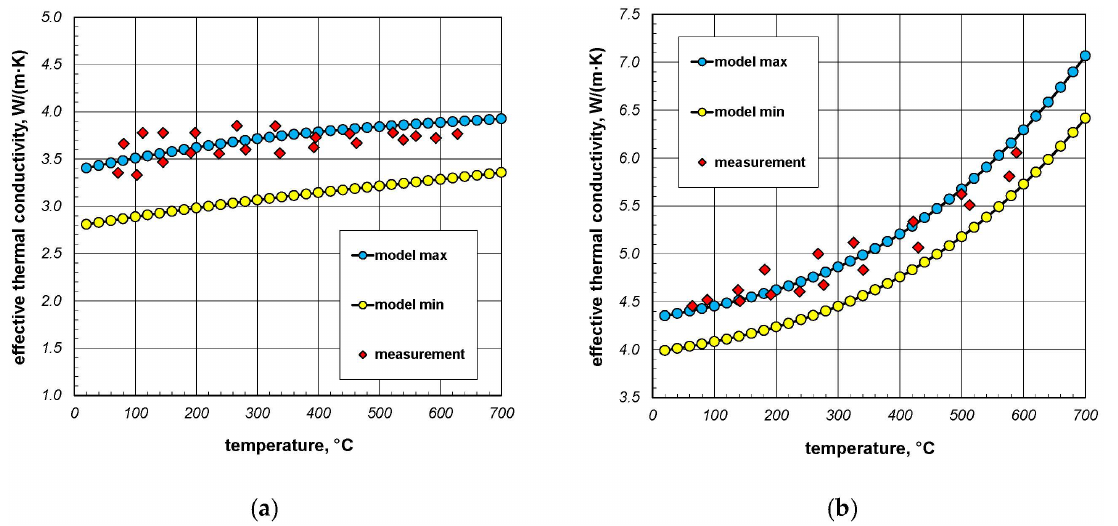
Figure 27. A comparison of model and measurement values of the effective thermal conductivity of section packages: ( a ) 20 × 40 mm sections; ( b ) 60 × 60 mm